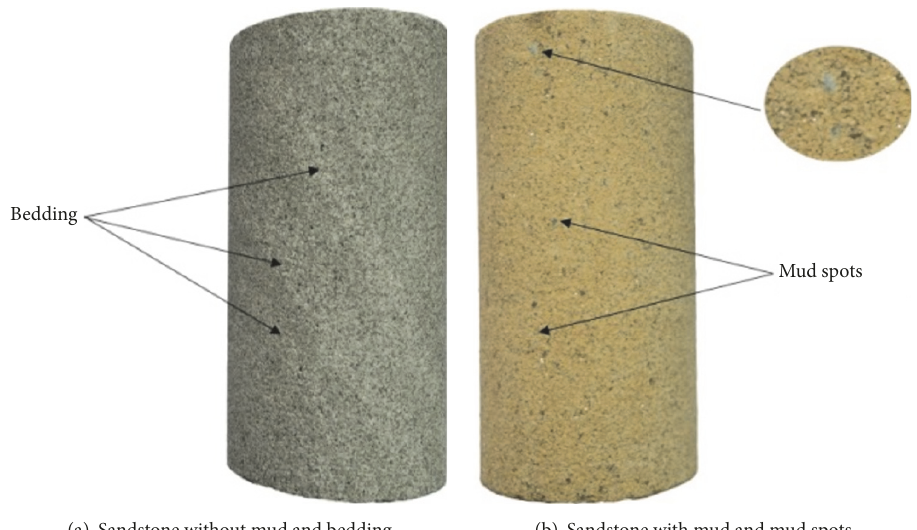
Figure 1: Reservoir sandstone and physical properties.